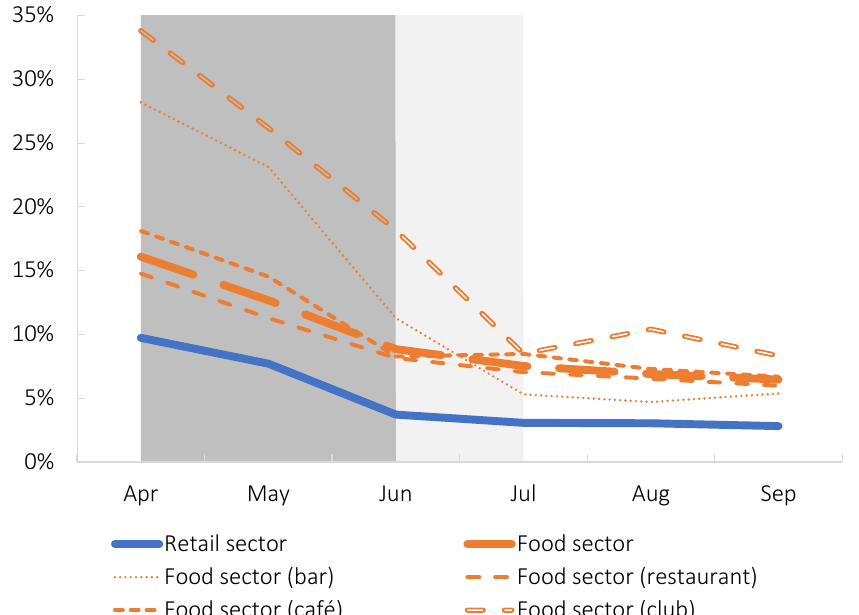
Figure 3. Evolution of the rate of businesses temporarily closed in 2021. Note: The monthly rate of temporarily closed businesses for the core downtown of Ottawa/Gatineau is derived from Google Places. The food sector is the aggregation of the results by the keywords bar , cafe , restaurant and night_club . Note that the point in April for the retail sector is an estimate based on a smaller sample. The dark grey shaded area corresponds to the lockdown and stay-at-home policies, while the light grey area corresponds to the extended period of restrictions only for night